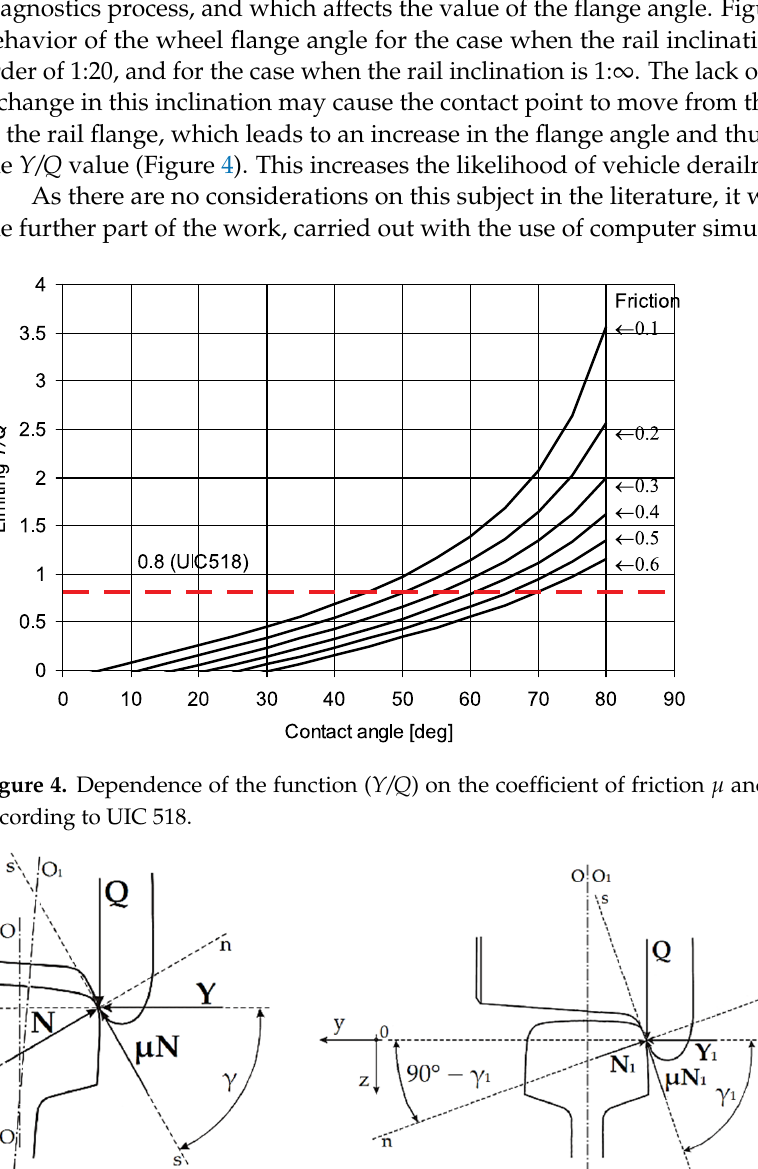
Figure 5. Distribution of forces acting at the point of contact of the wheel with the rail in the case of rail inclination ( a ) and in the case of no rail inclination ( b ).